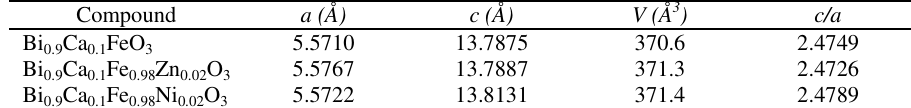
Table 1. Some structural parameters of the Ca-doped BiFeO